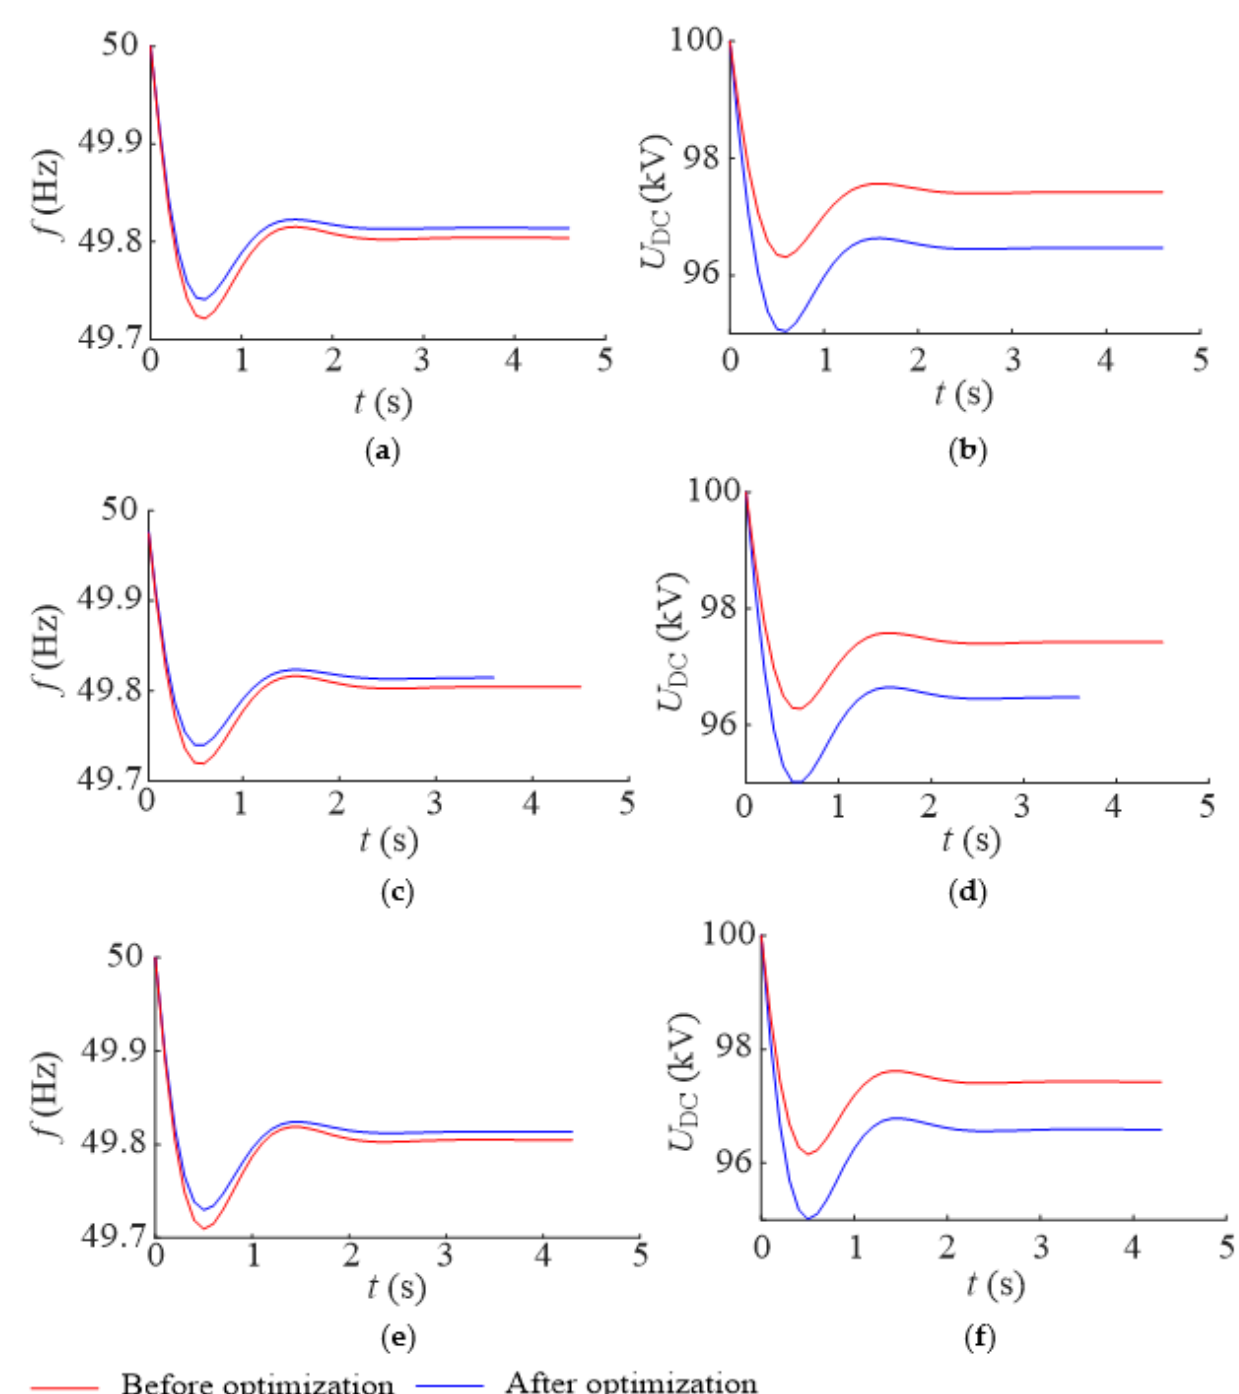
Figure 9. Comparison of dynamic power flows before and after optimization of H DC : ( a ) System frequency under low wind speed; ( b ) DC voltage under low wind speed; ( c ) System frequency under medium wind speed; ( d ) DC voltage under medium wind speed; ( e ) DC voltage under high wind speed; ( f ) DC voltage under high wind speed.